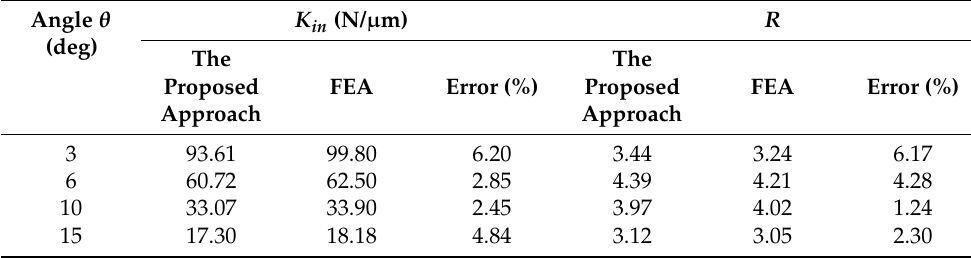
Table 2. Comparison results of static performances.